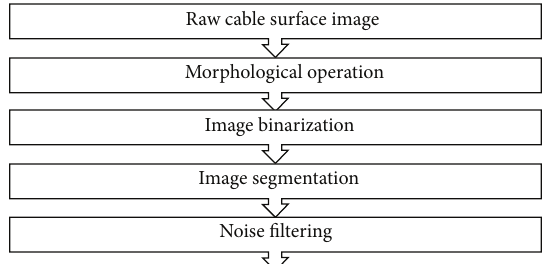
Figure 26: Morphological technique-based crack detection algo- rithm on cable surface.